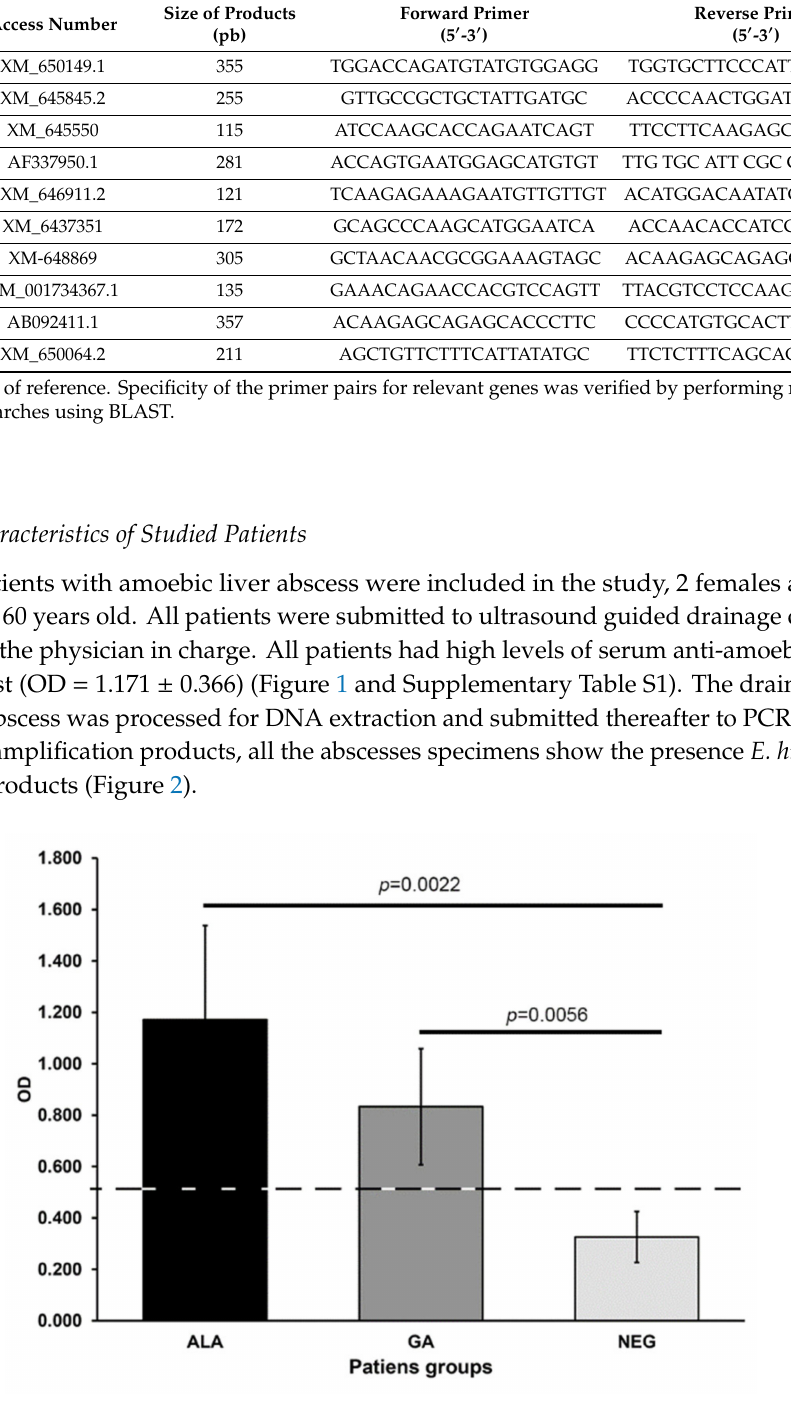
Figure 1. Reactivity of sera from patients with amoebic liver abscess (ALA) and cutaneous genital amoebiasis (GA). The reactivity of human IgG against E. histolytica antigen was measured, the average of the OD (590 nm) per group of patients is represented here. Cutline defined as the mean of the respective OD values obtained from non-parasitized individuals (Negative group) plus two standard deviations (0.525) and results previously reported [25]. Statistical significance was included ( p ≤ 0.05). The individual dates are in the Supplementary Table